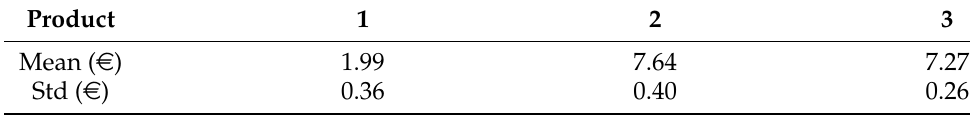
Table 1. Mean and standard deviation of the weekly prices time